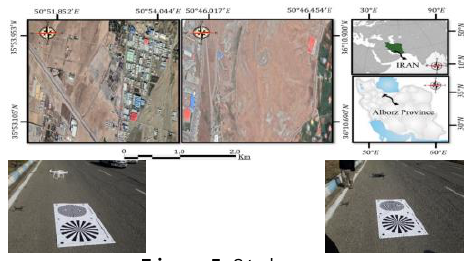
Figure 5. Study area.